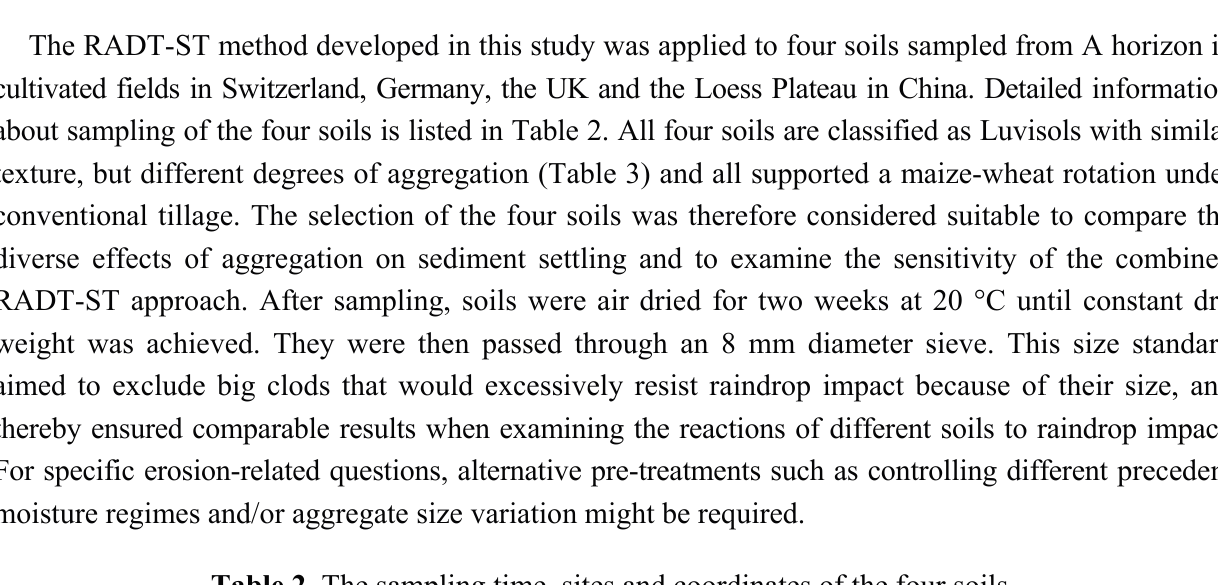
Table 2. The sampling time, sites and coordinates of the four soils.